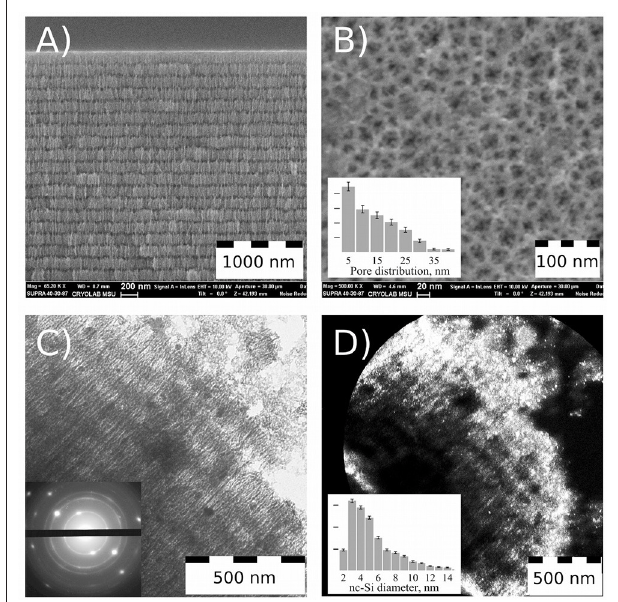
FIGURE 1 | Electron microscope study of Perf-PSi. SEM images of Perf-PSi layer: cross-sectional view (A) and plan-view (B) ; Pore distribution, calculated from SEM image (inset B ); TEM image of Perf-PSi piece, that was isolated midway through the ultrasonic fracturing process (C) ; Electron diffraction pattern corresponding to TEM image (inset C ); Dark-field image of the same piece (D) . Bright spots correspond to silicon nanocrystals; Diameter distribution of the nanocrystals (inset D